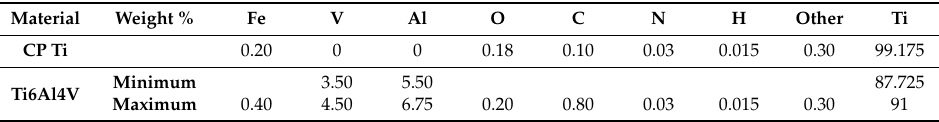
Table 2. Nominal weight composition of commercially pure titanium (CPTi) and Ti6Al4V used for the implant production.